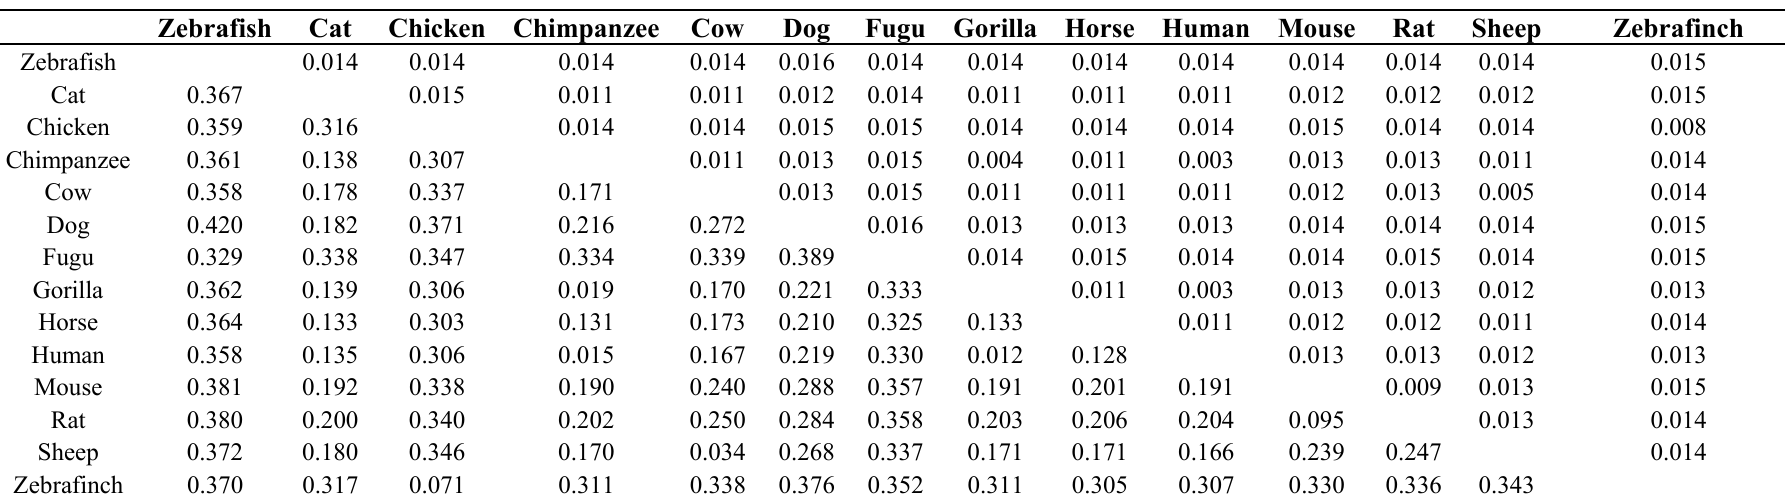
Table 3. Estimates of MTNR1A evolutionary divergence (below diagonal) and standard errors (above diagonal) between sequences. Zebrafish Cat Chicken Chimpanzee Cow Dog Frog Fugu Gorilla Horse Human Mouse Rat Sheep Zebrafinch Zebrafish 0.014 Cat 0.014 Chicken 0.276 Chimpanzee Cow 0.297 Dog 0.281 0.012 Frog 0.287 0.310 0.012 Fugu 0.013 Gorilla 0.275 0.013 Horse 0.274 0.013 Human Mouse Rat